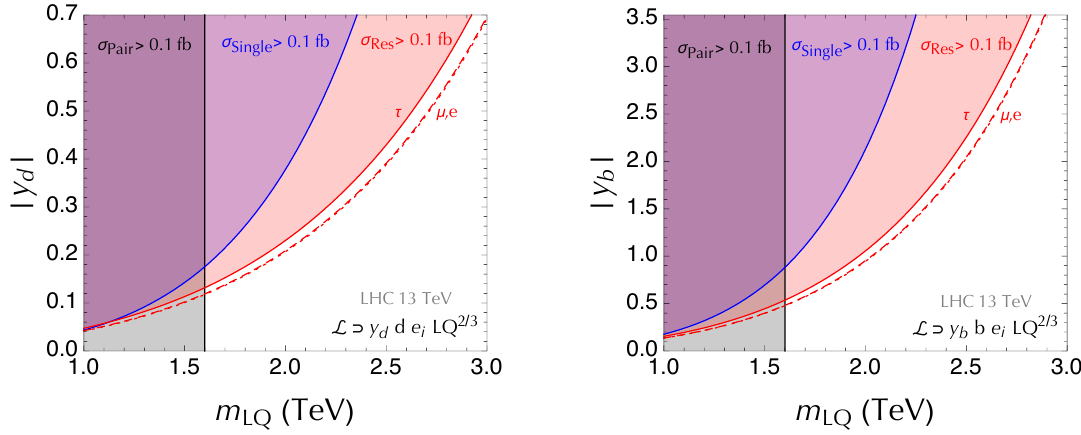
Figure 2 . Comparison of cross sections for three leptoquark production mechanisms at the LHC √ ( s = 13 TeV). Shaded regions show the parameter space in the leptoquark mass versus coupling plane for which the corresponding cross sections are > 0 . 1 fb. The pair production pp → S † cross section is shown in black, while the single ( pp → S Q S Q )+ c.c. cross sections are shown in blue and red, respectively. In the left (right) panel, the LQ leptoquark interacts primarily with the down (bottom) quark. The lepton flavors in the resonant production are shown with solid ( τ ), dashed ( µ ) and dotted ( e ) lines. The electric charge of S Q is set to Q LQ = 2 / 3 , however, the difference is negligible for Q = 4 / 3 . For consistency, all cross sections are computed at NLO QCD (plus NLO QED for the resonant process) with the same central PDF set LUXlep-NNPDF31_nlo_as_0118_luxqed (v2) [47]. The first two processes are computed using the leptoquark toolbox [23], while the resonant production is taken from section 3. The pair production from the t -channel leptoquark exchange is negligible in this coupling